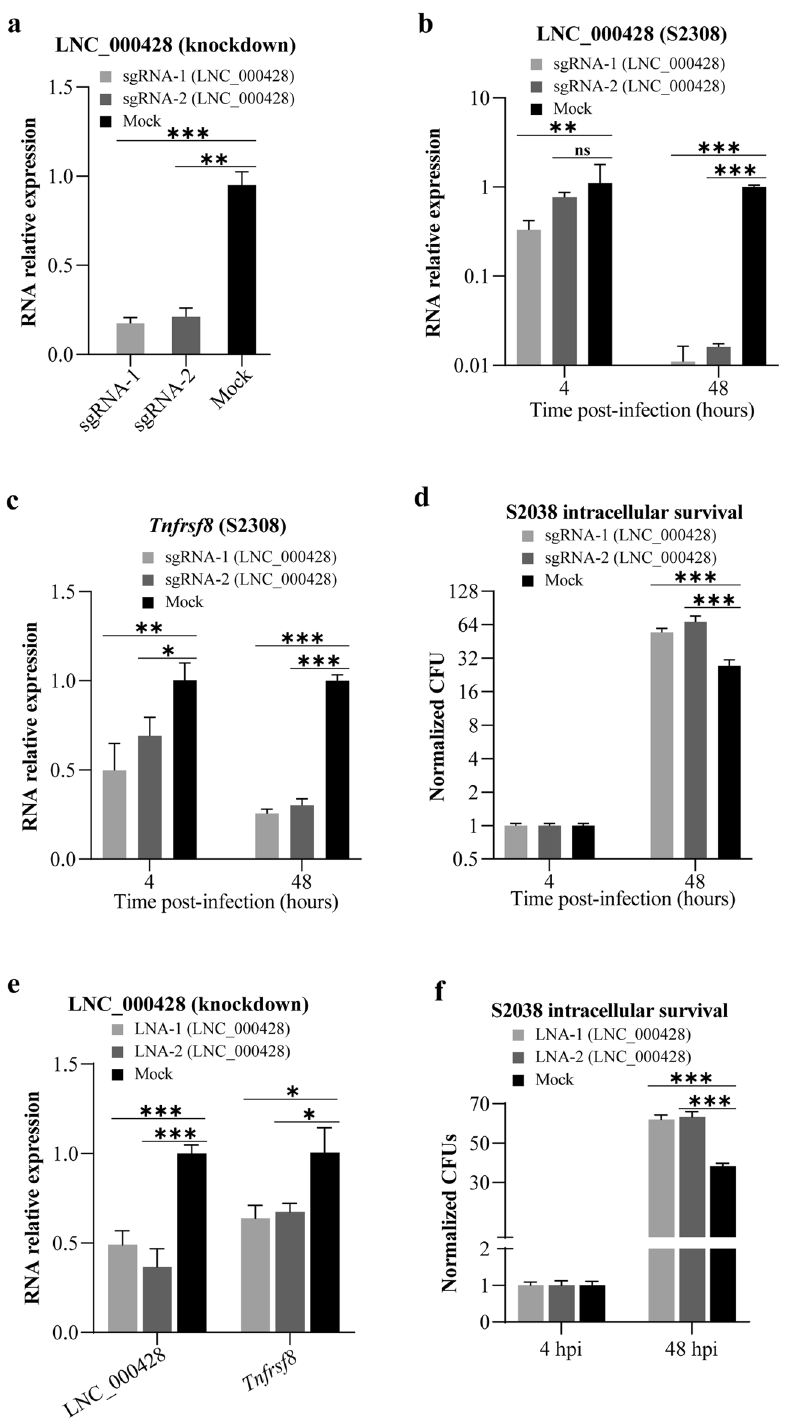
Figure 7. LNC_000428 knockdown in RAW264.7 cells impacting Brucella -induced Tnfrsf8 expression and Brucella intracellular survival. ( a ) LNC_000428 expression in cell lines from which lncRNA expression in RAW2647 cells is knocked down by the CRISPR/ dCas9 inhibition system. Expression of LNC_000428 ( b ) and Tnfrsf8 ( c ) induced by S2308 infection in lncRNA knockdown cell lines was detected by qRT-PCR, while the cells were infected with S2308 at an MOI of 1000 for 4 and 48 h. Relative RNA expression was decided by normalizing the expression of lncRNA to Gapdh . ( d ) Impacts of LNC_000428 knockdown in RAW264.7 cells on Brucella intracellular survival were shown by determination of the intracellular bacterial with CFUs while cell lines were infected with S2308 at a MOI of 1000 for 4 and 48 h. All data at 48 hpi were normalized to 4 hpi when bacterial CFU at each time point was divided by mean of CFUs at 4 hpi. ( e ) Locked Nucleic Acids (LNAs) targeted to LNC_000428 were delivered into RAW264.7 cells by TurboFect Transfection Reagent. At 24 h post transfection, expression of LNC_000428 and Tnfrsf8 were determined by qRT-PCR. ( f ) Impacts of LNC_000428 knocked down expression by LNAs in RAW264.7 cells on Brucella intracellular growth. Bacterial CFUs were monitored at 4 and 48 hpi. All data at 48 hpi were normalized to 4 hpi when bacterial CFU at each time point was divided by mean of CFUs at 4 hpi. * P < 0.05; ** P < 0.01; *** P < 0.001. ns: not